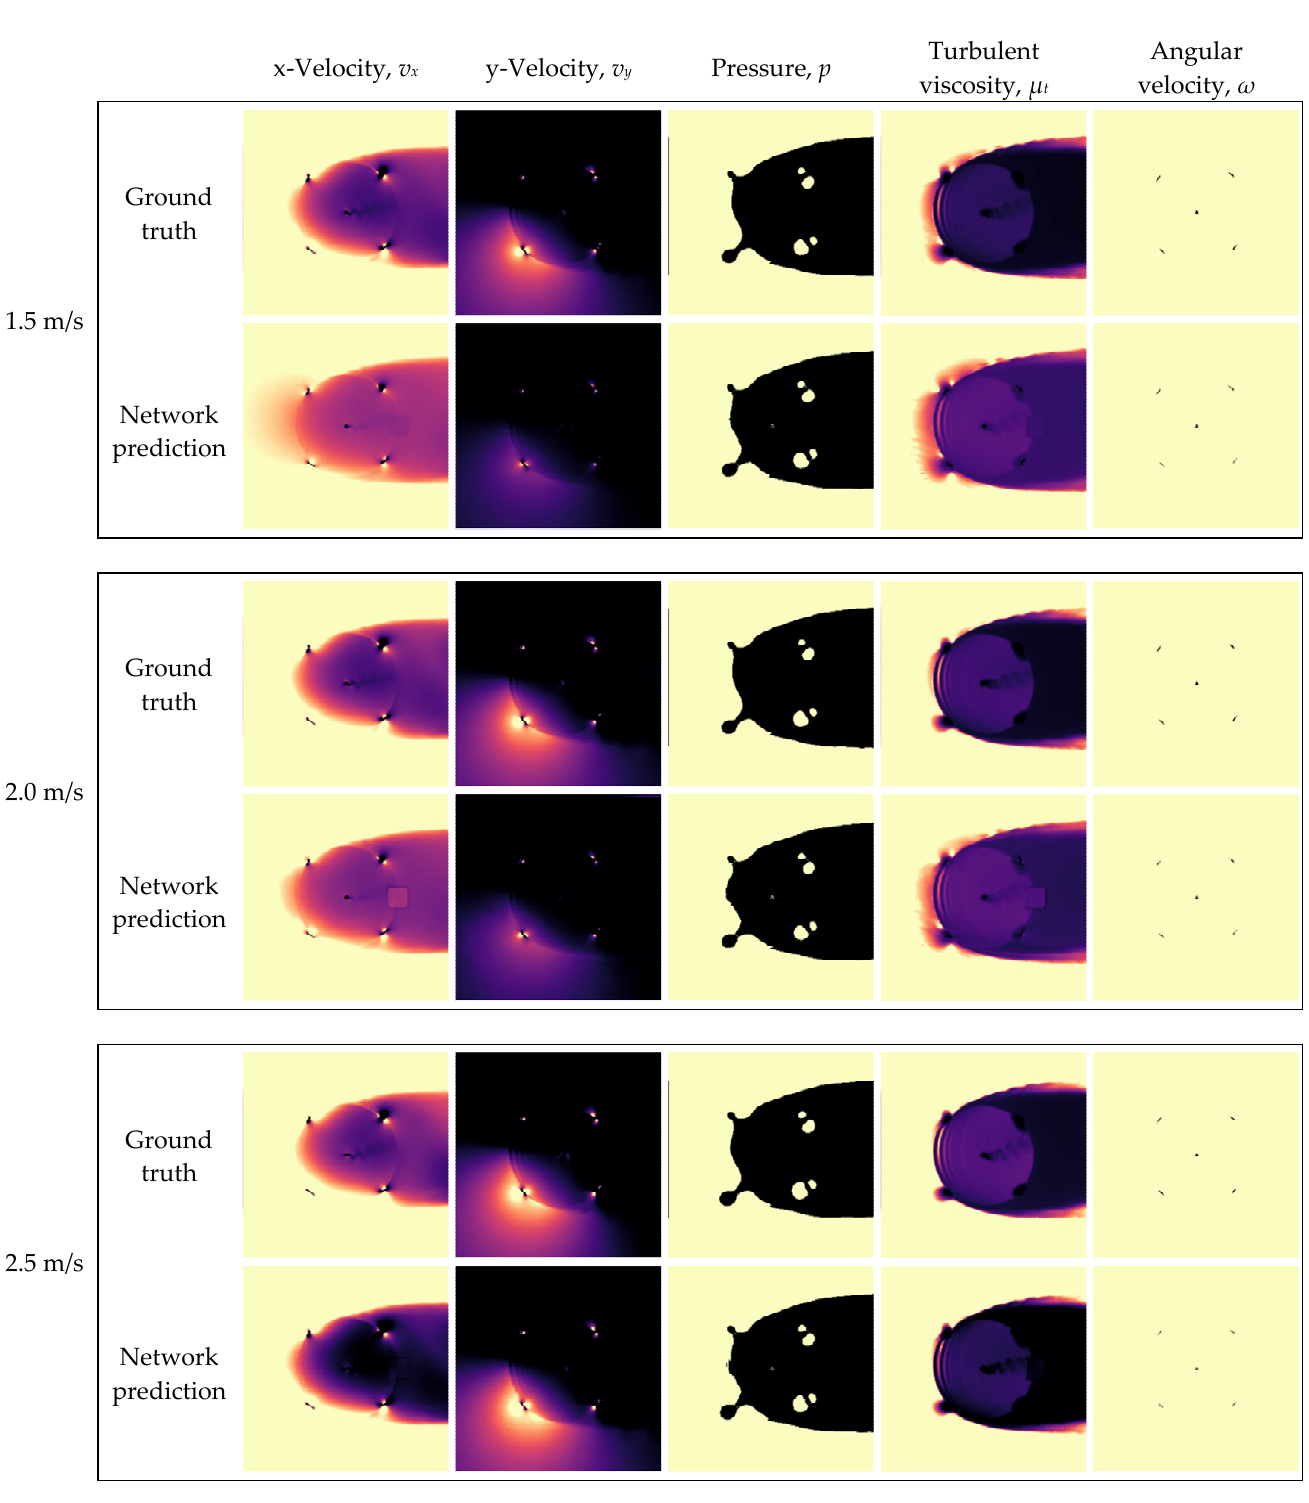
Figure 22. Ground truths and network predictions of Model 1 for the testing cases of v ∞ = 1.5, 2.0, and 2.5 m/s.